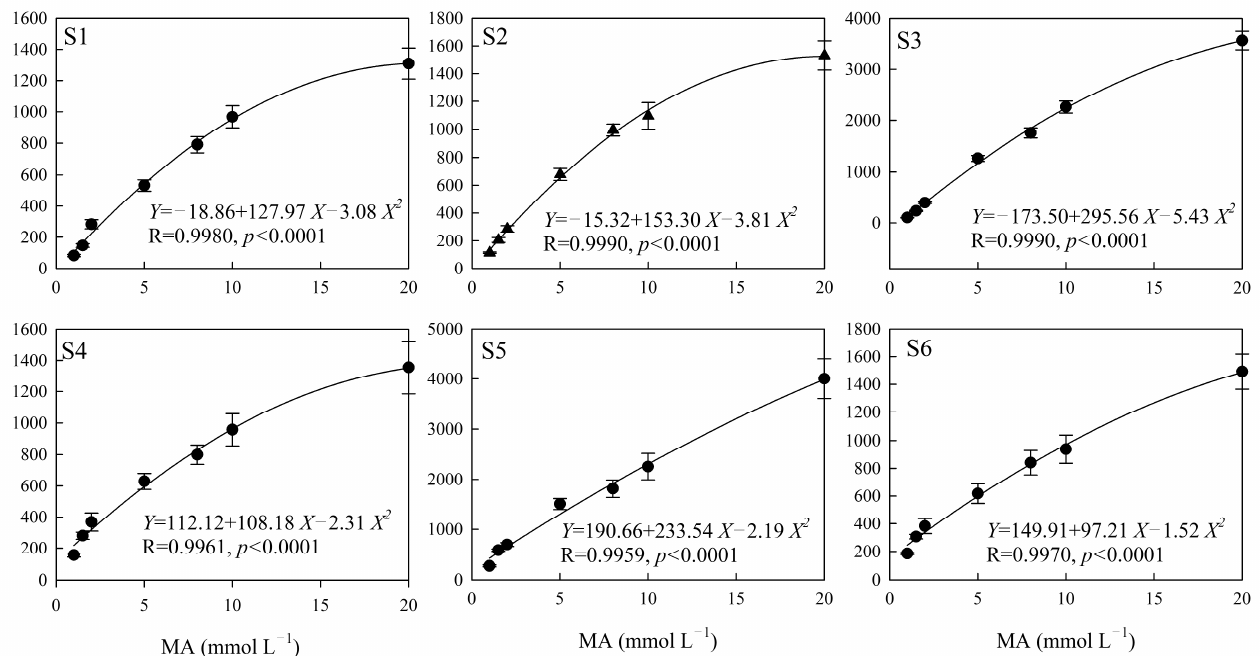
Figure 4. The P extraction efficiency induced by different concentrations of TA. Note: X is the concentration of TA (mmol L − 1 ), Y is the P extraction efficiency of TA (%), R is the correlation coefficient of the fitting equation, and p -value is the significant difference. S1, S2, S3, S4, S5 and S6 are six sampling areas.